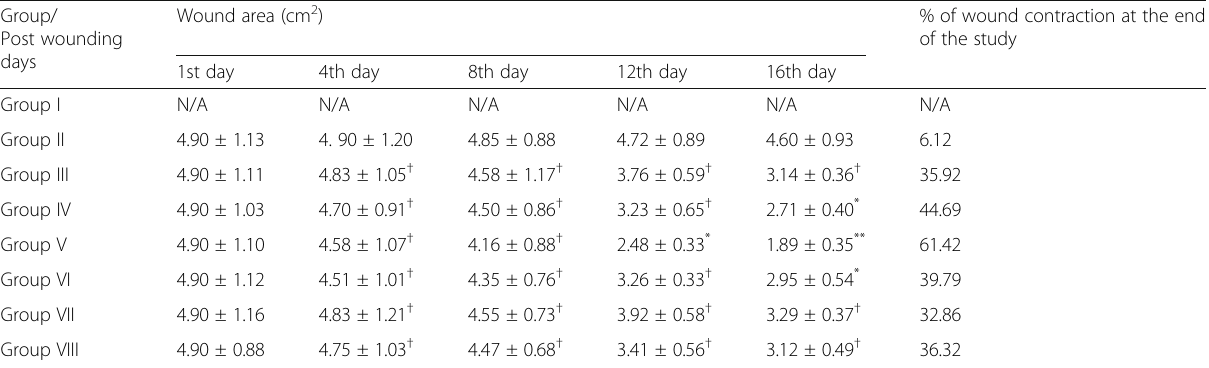
Table 3 Effect of ethanolic extract of E. hirta whole plant on excision wound in alloxan induced diabetic rats Group/ Post